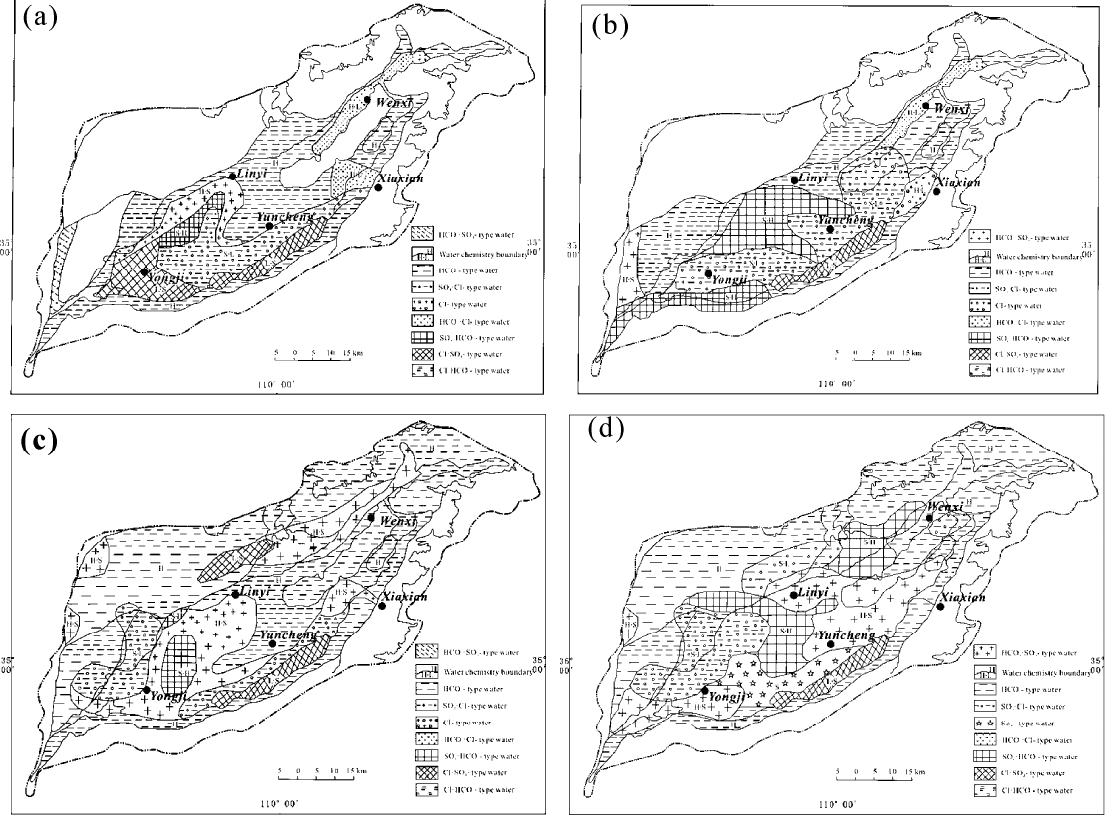
Figure 2. The hydrochemical facies of groundwater at Yuncheng Basin in 2005 (( a ), shallow groundwater; ( c ), intermediate-deep groundwater) [34] and 2015 (( b ), shallow groundwater; ( d ), intermediate-deep groundwater).